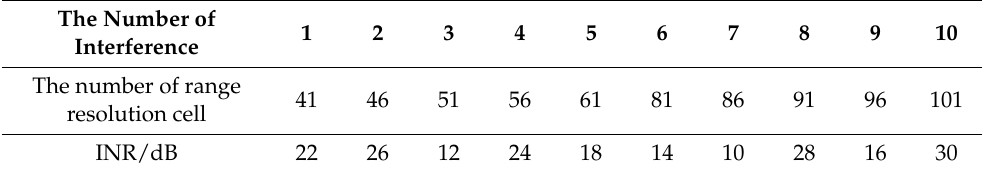
Table 2. Interference Target Location and INR.